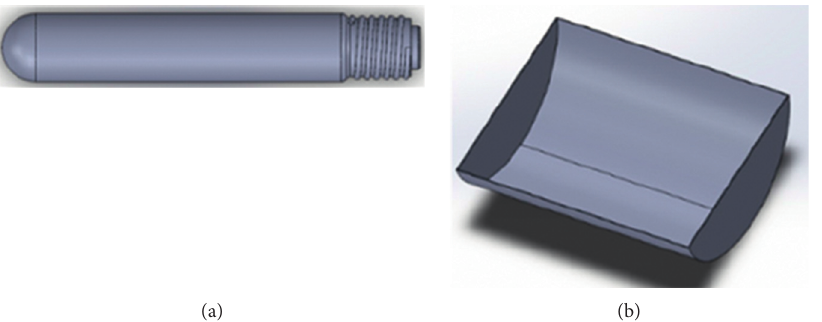
Figure 8: (a) Model of ORSAM VIALOX NAV-T SUPER 4Y series 400W sodium lamp; (b) model of the initial designed reflector of the proposed counterbeam light.